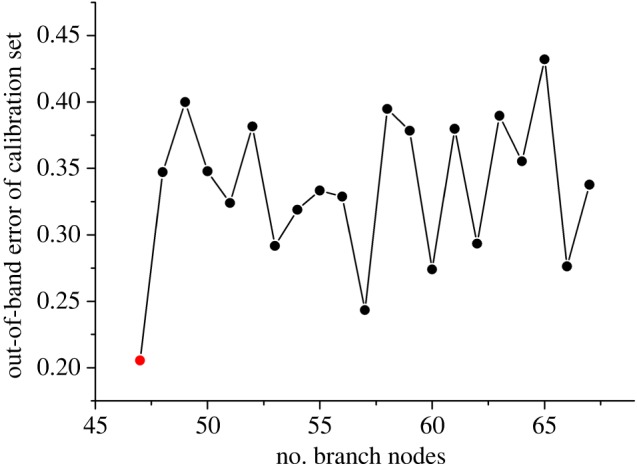
The selection results of mtry using the low-level fusion strategy.